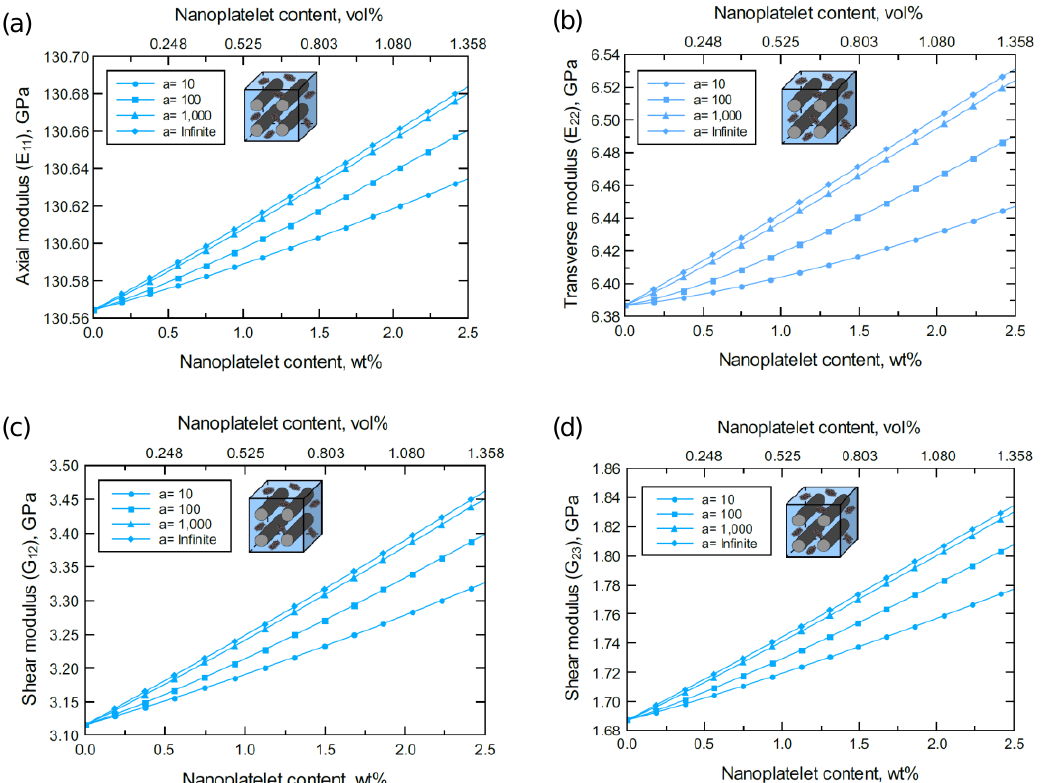
Figure 9. Predicted elastic and shear moduli for unidirectional CF/FGO/epoxy for various nanoplatelet content and aspect ratio values; ( a ) axial elastic modulus 𝐸 11 , ( b ) transverse elastic modulus 𝐸 22 , ( c ) shear modulus 𝐺 12 , ( d ) shear modulus 𝐺 23 . The volume fraction of CF is 56%.